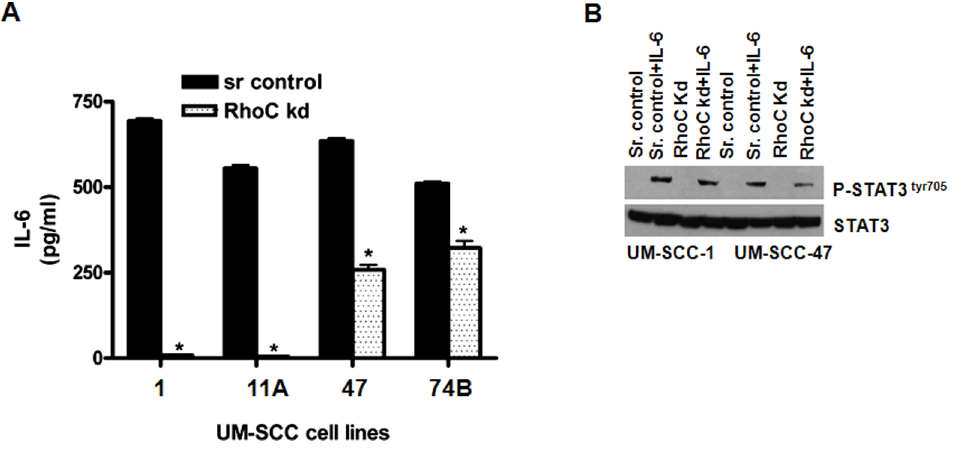
Figure 6. Effect of IL-6 in STAT3 phosphorylation in HNSCC cell lines. (A) A dramatic decrease in the IL-6 expression in the RhoC knockdown cell lines were obtained by ELISA (p # 0.05). (B) Phosphorylation of STAT3 tyr705 in the scrambled control and the RhoC knockdown cell lines after IL-6 stimulation. Notice IL-6 stimulates STAT3 tyr 705 phosphorylation even in the RhoC knockdown clones in UM-SCC-1 and -47 respectively.